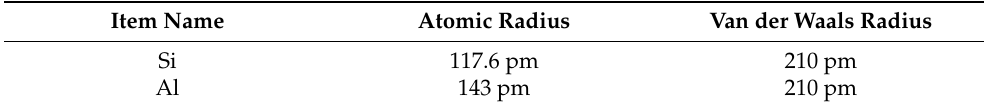
Table 1. Geometric characteristics of elements Si, Al.